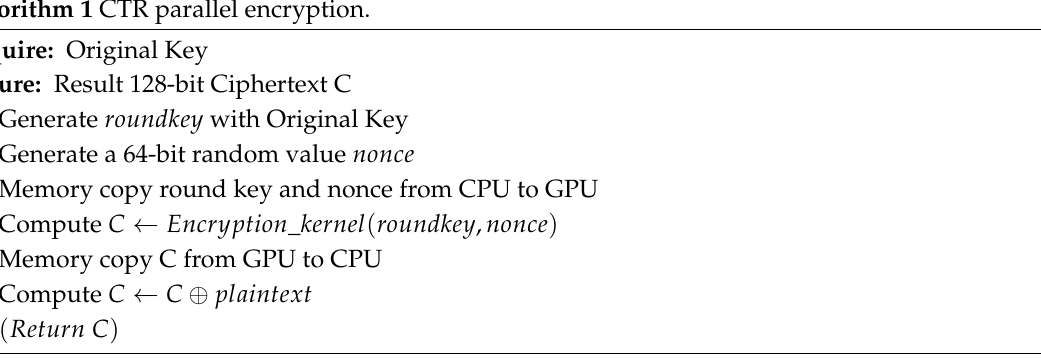
Algorithm 1 CTR parallel